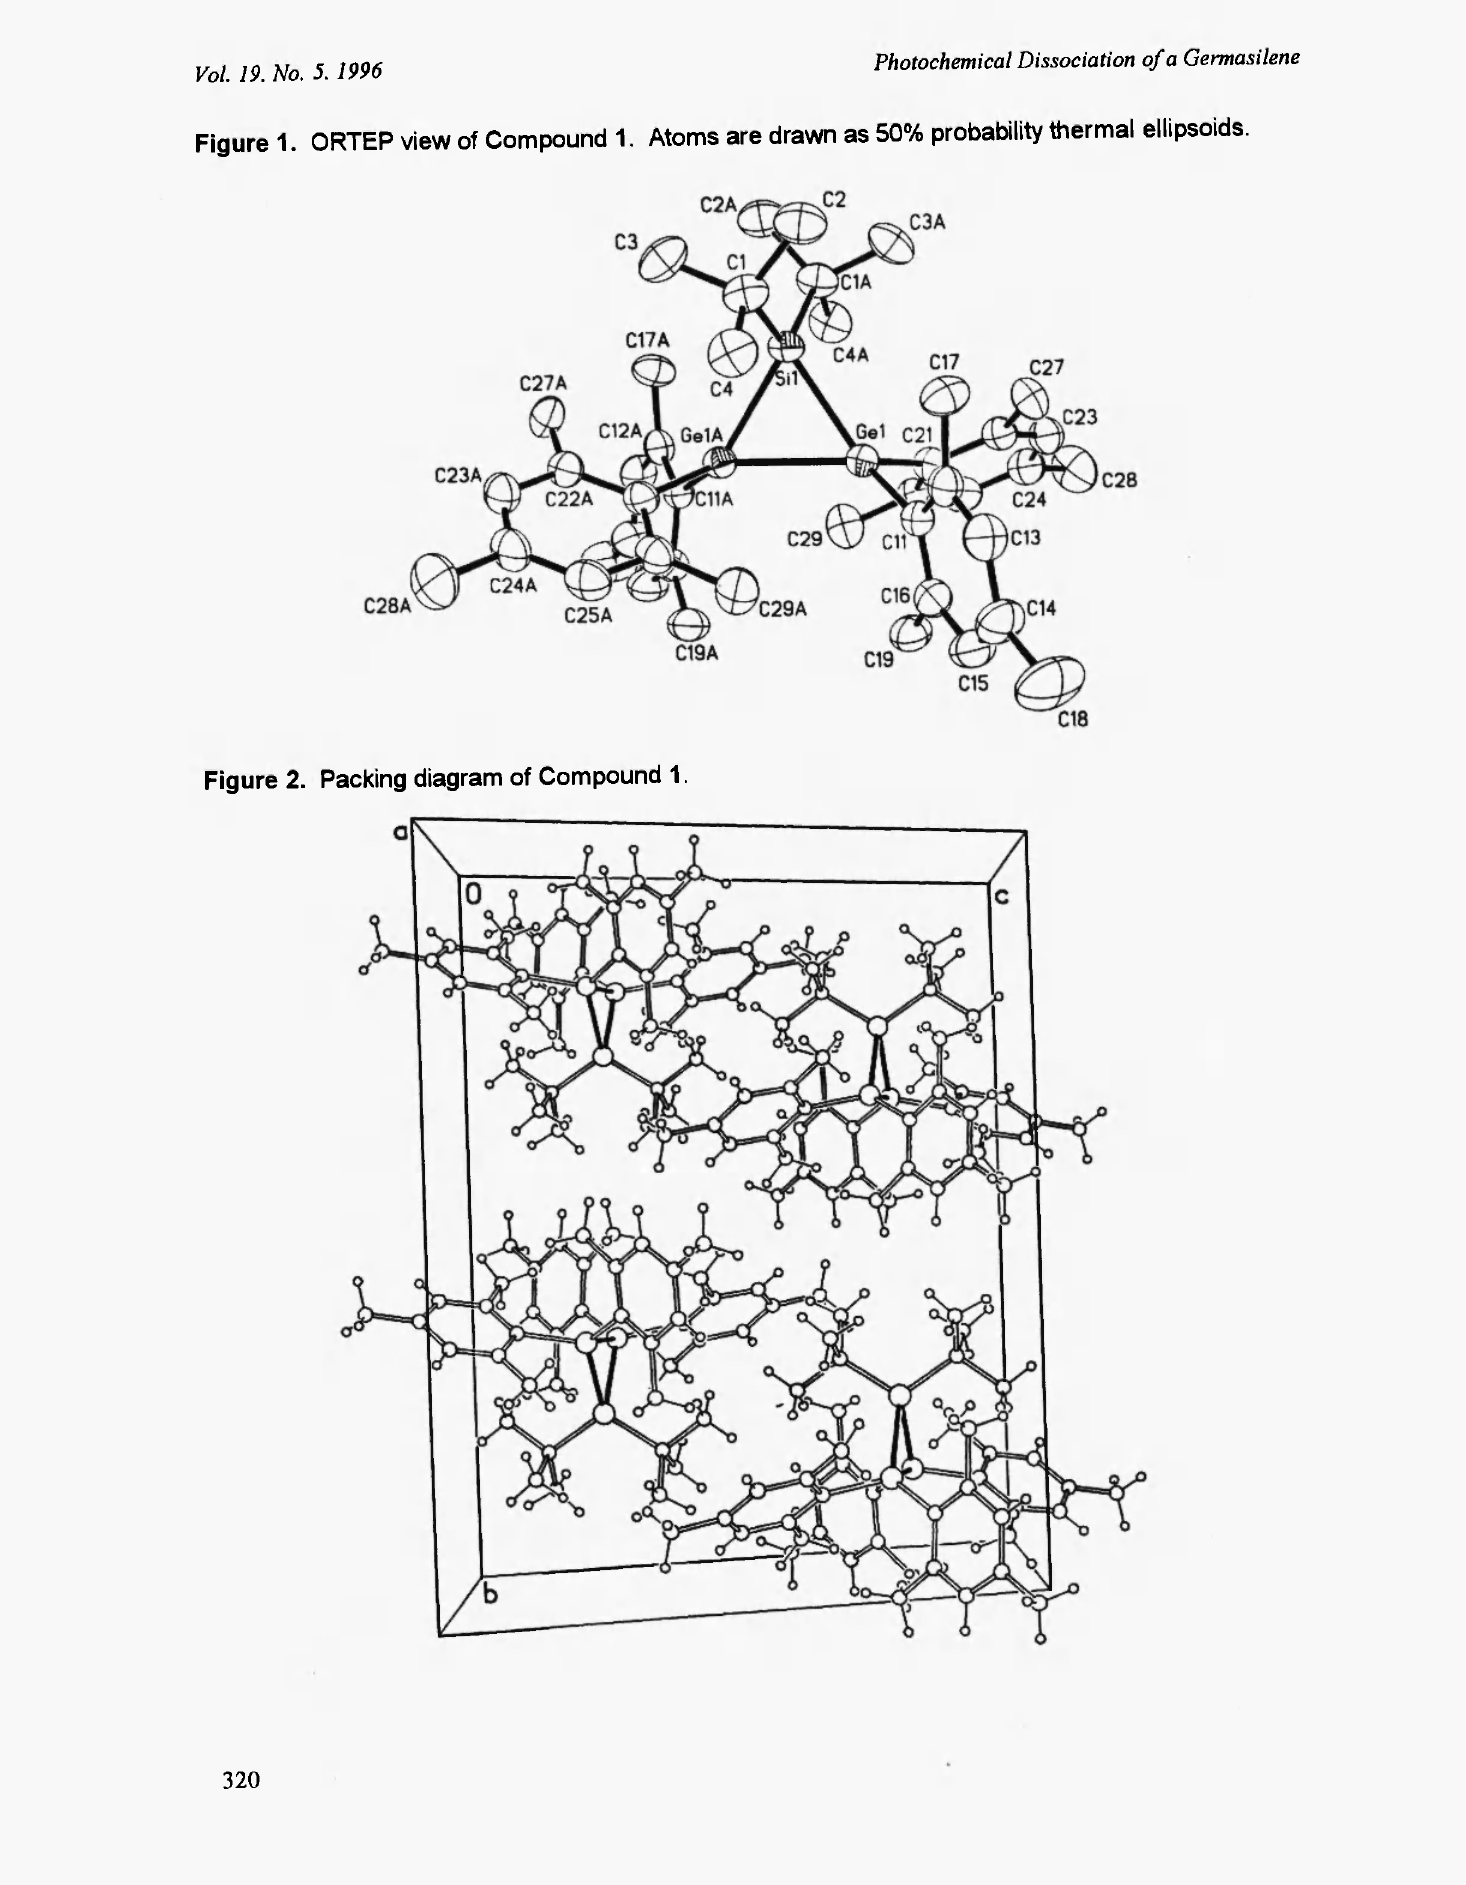
Figure 1. ORTEP view of Compound 1. Atoms are drawn as 50% probability thermal ellipsoids.